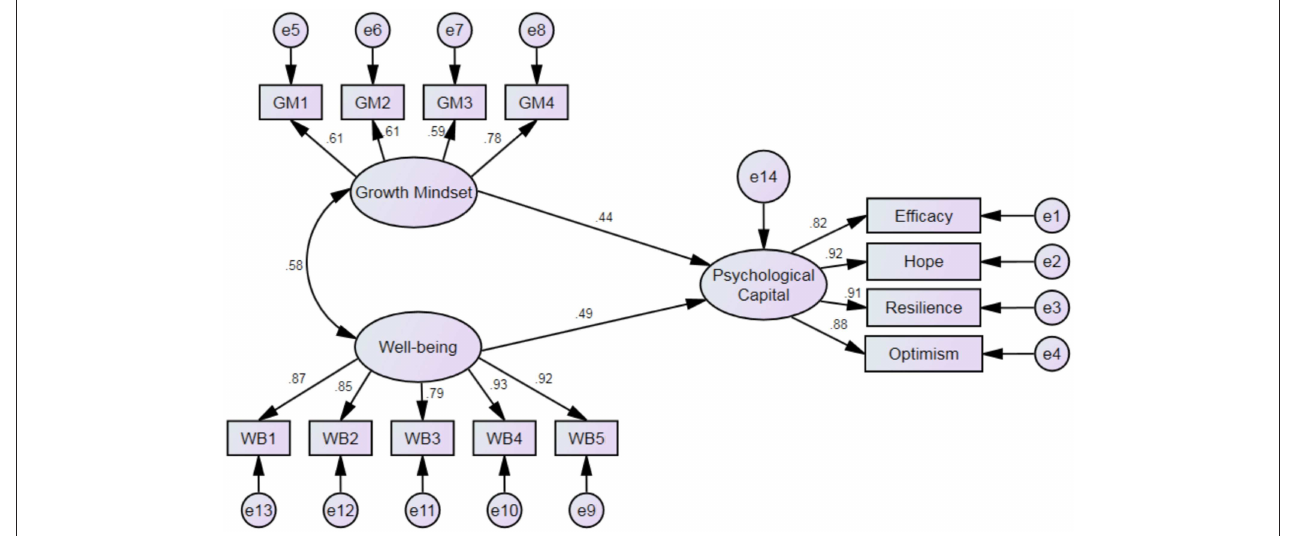
FIGURE 2 | Standardized estimated results of SEM for growth mindset, well-being and psychological capital ( n =